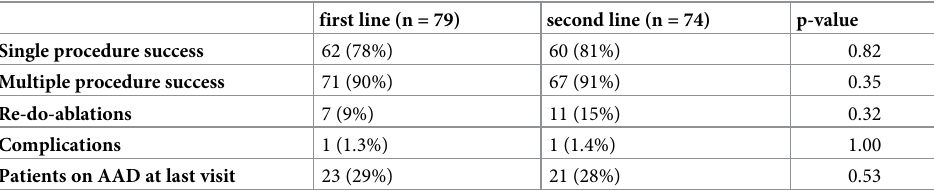
Table 3. Outcomes after